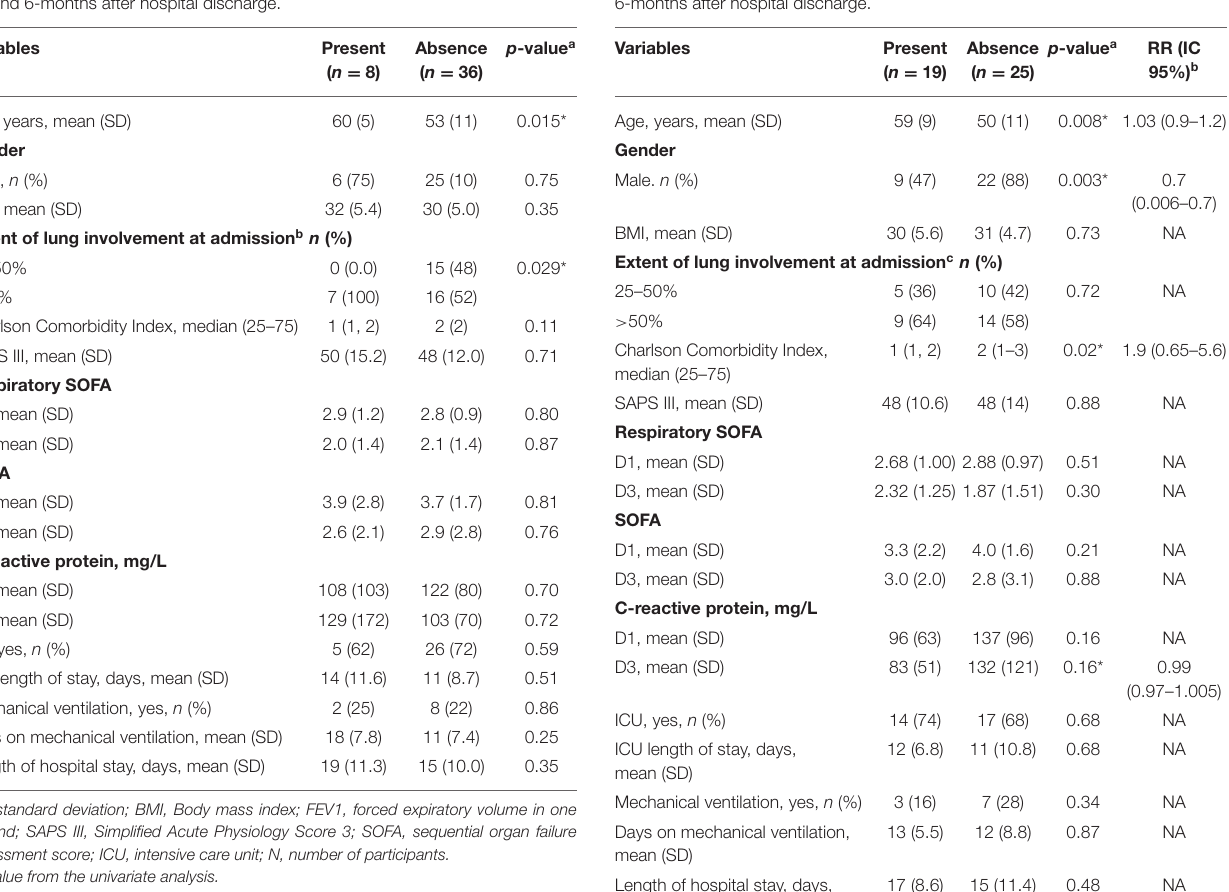
TABLE 4 | Variables associated with a decreased forced expiratory volume in one second 6-months after hospital discharge. Variables Present